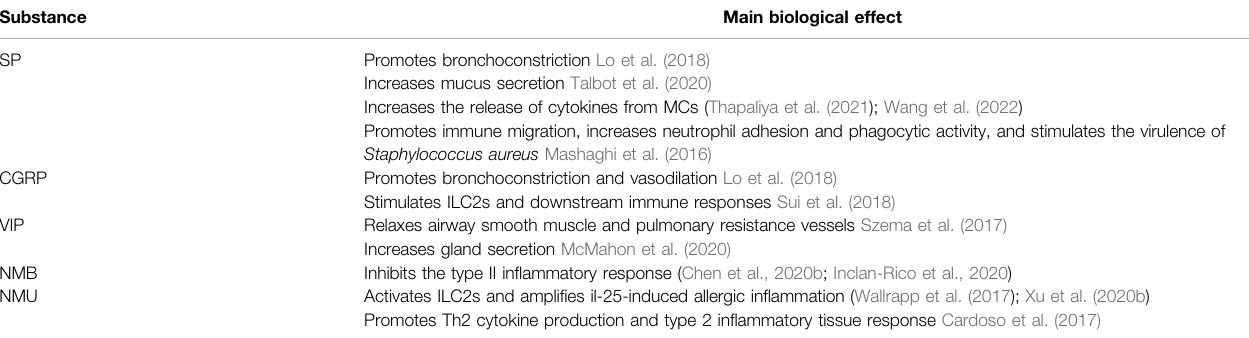
TABLE 3 | The role of neuropeptide in pulmonary neuroimmune crosstalk.